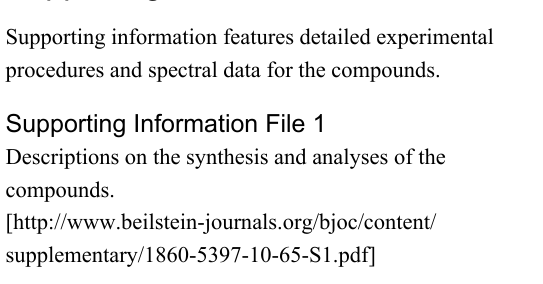
dents with absorption spectral data and theoretical calculations